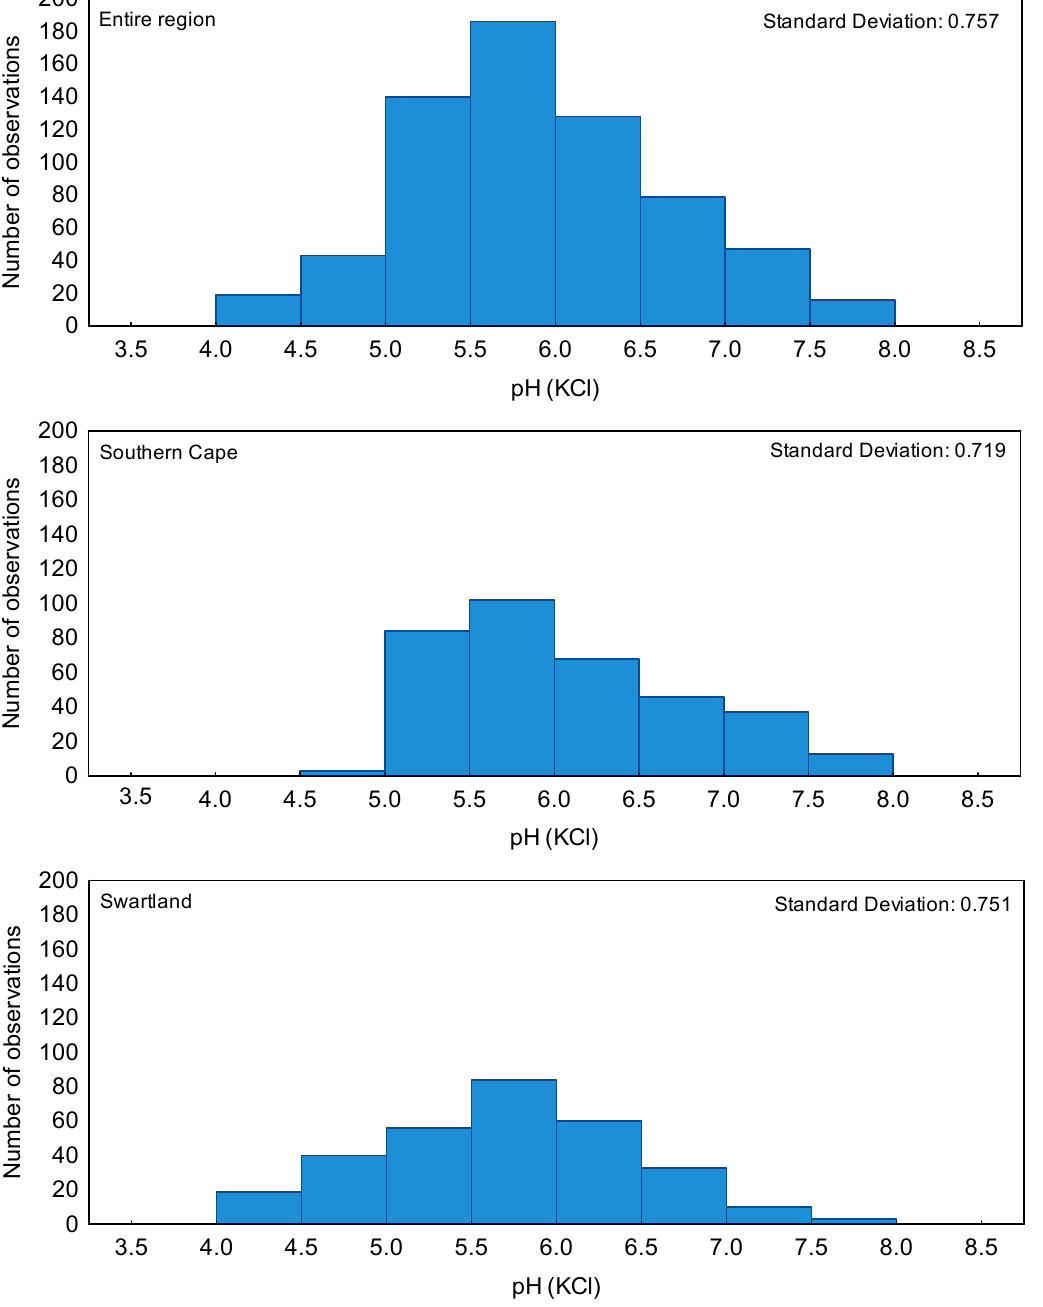
Figure 1. The mean soil pH (KCl) distribution for all samples ( top ) as well for the southern Cape ( middle ) and the Swartland ( bottom ) regions separately.